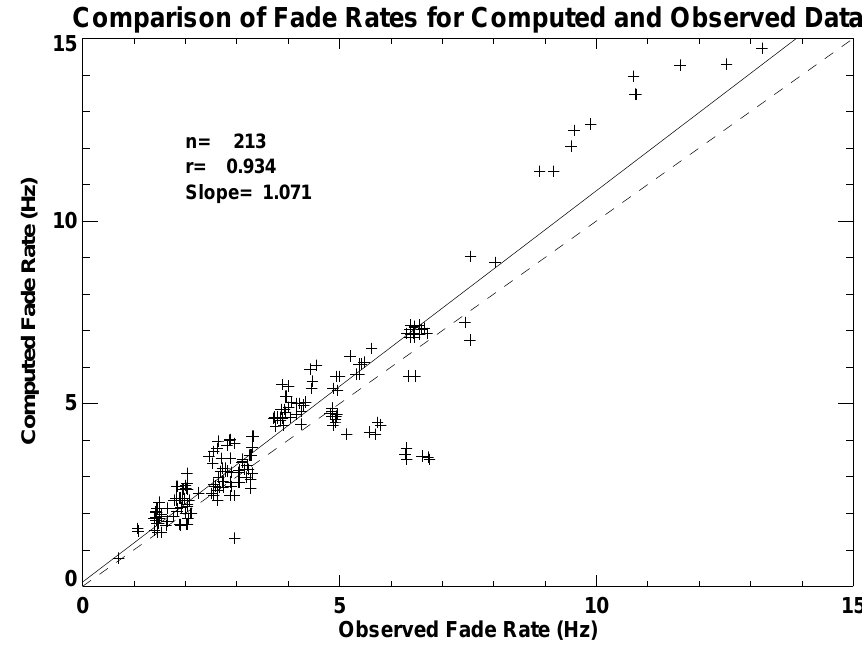
Fig. 5. A linear regression comparison of all computed and observed Faraday fade rates for the ISIS II experiment. The dashed line is the ideal fit and the solid line is the best fit. The regression analysis used 213 points and gave a regression coefficient of 0.934 and a slope of